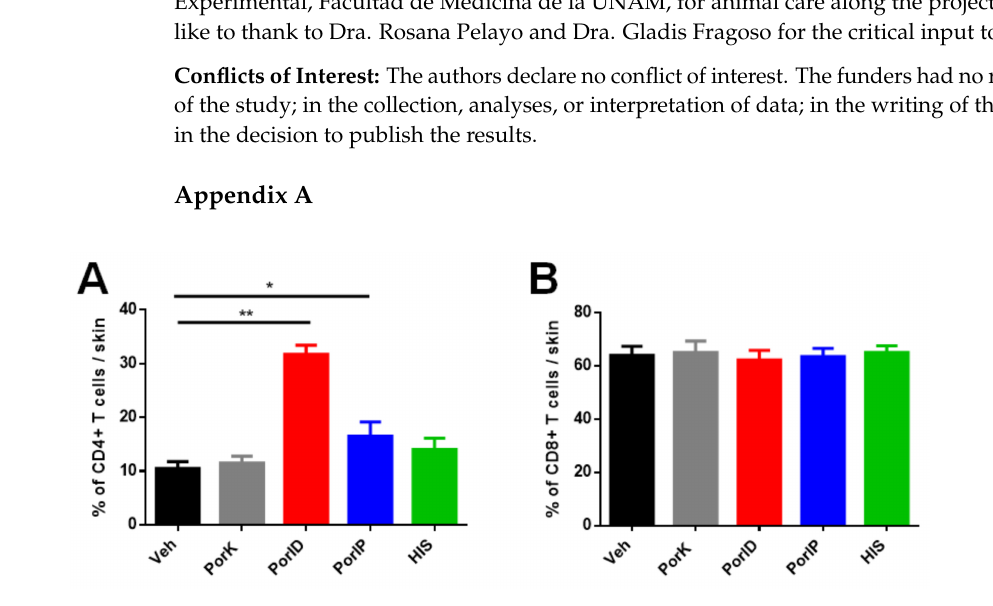
Figure A1. Percentage of CD4+ and CD8+ T cells in skin. C57BL/6J mice were injected intradermally in the ear with vehicle (Veh), proteinase K-digested porins (PorK), porins (PorID), or intraperitoneally with porins (PorIP) or heat-inactivated S . Typhi (HIS) at day 0. All groups were boosted at day 14 with porins injected intradermally in the ear. Count of the percentage of CD4+ ( A ) and CD8+ ( B ) T cells found in skin at day 28. ( n = 7; 2 independent experiments; significant difference for a Kruskal–Wallis test ** p < 0.05 * p < 0.1 with Dunn’s multiple comparison).